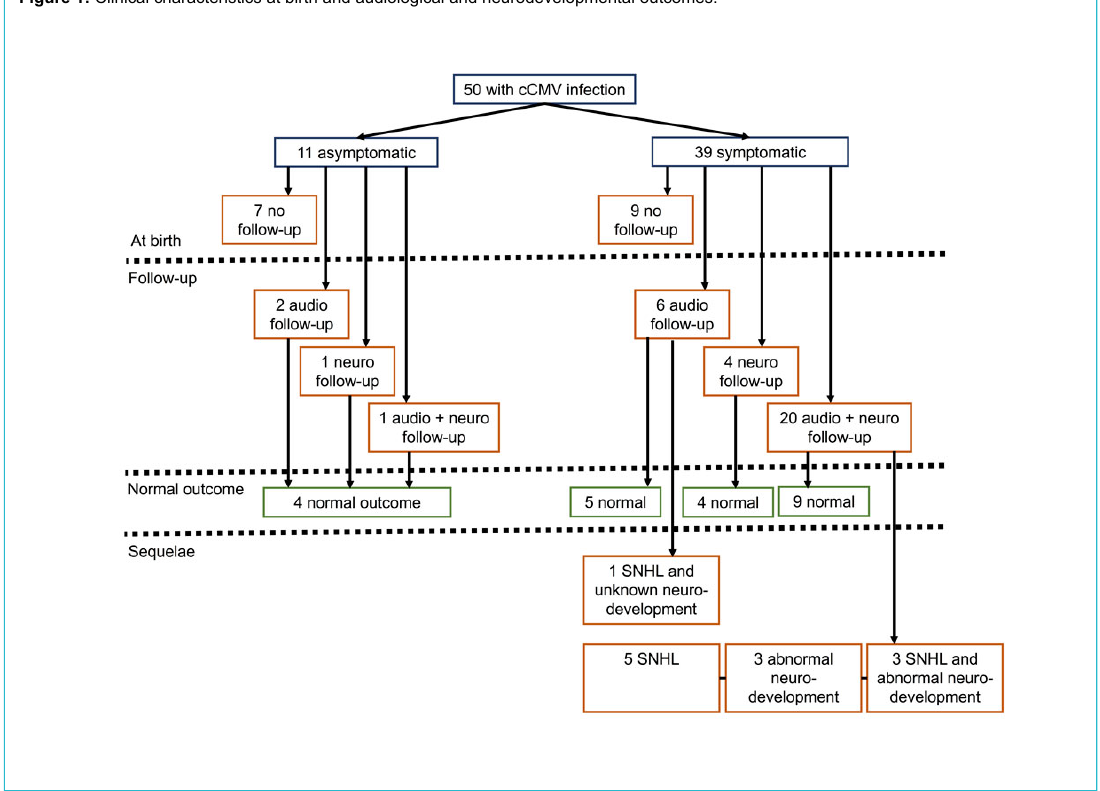
Figure 1: Clinical characteristics at birth and audiological and neurodevelopmental outcomes.